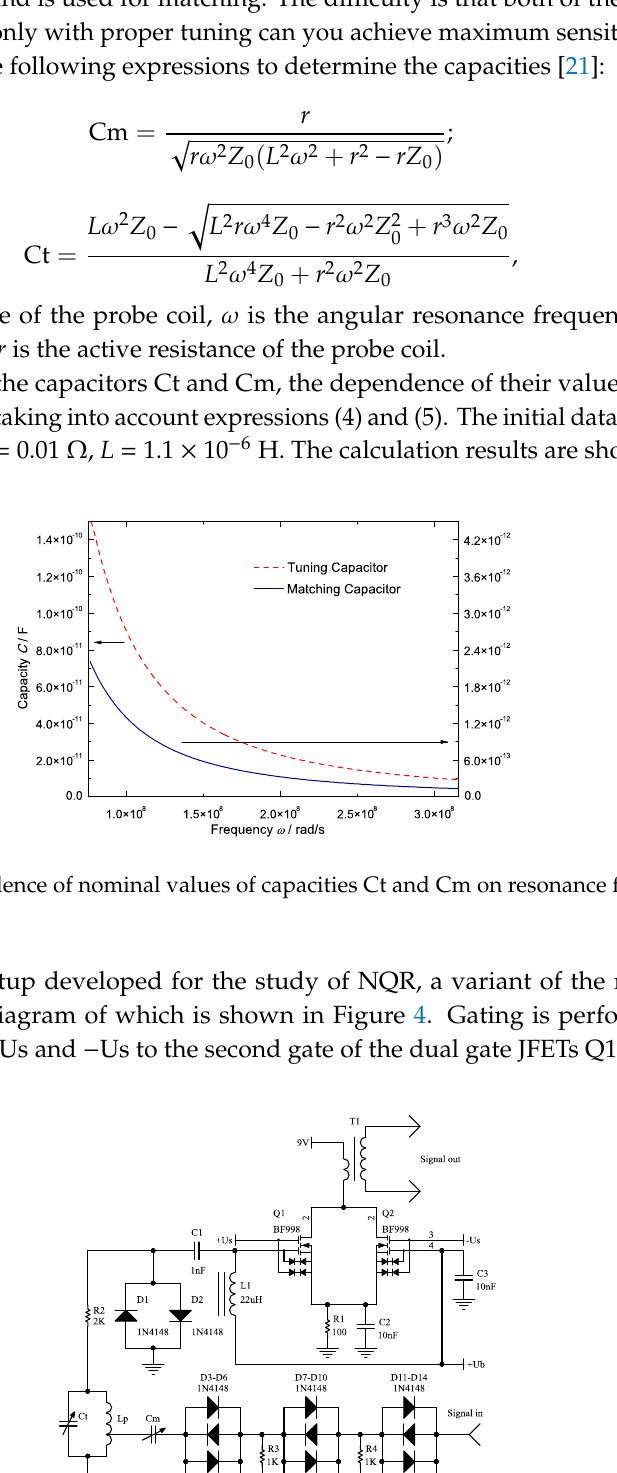
Figure 5. Transient process in the spin signal amplifier: ( 1 ) Without a suppression circuit; ( 2 ) With the application of the proposed transient suppression circuit; ( 3 ) Gating pulse. A key device for protecting a wideband preamplifier was proposed by Rudakov [22], but the carrier frequency suppression ratio was only 60 dB. In our case, effective gating of the device (up to 100 dB) is provided by three subsequent pairs of same-type dual gate JFETs connected in parallel with respect to the power source (Figure 6). The circuit diagram and printed circuit board (PCB) of the analog signal chain are designed using Altium Designer software. The PCB (Figure 7a) is located in a metal case, where electromagnetic shields are between the separate stages (Figure 7b).